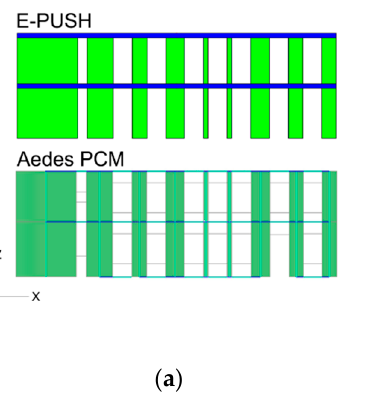
Figure 10. Comparison of capacity curves provided by Aedes PCM and E ‐ PUSH for the wall align ‐ ment no. 3 in Figure 9: ( a ) model of the wall alignment, ( b ) capacity curves.